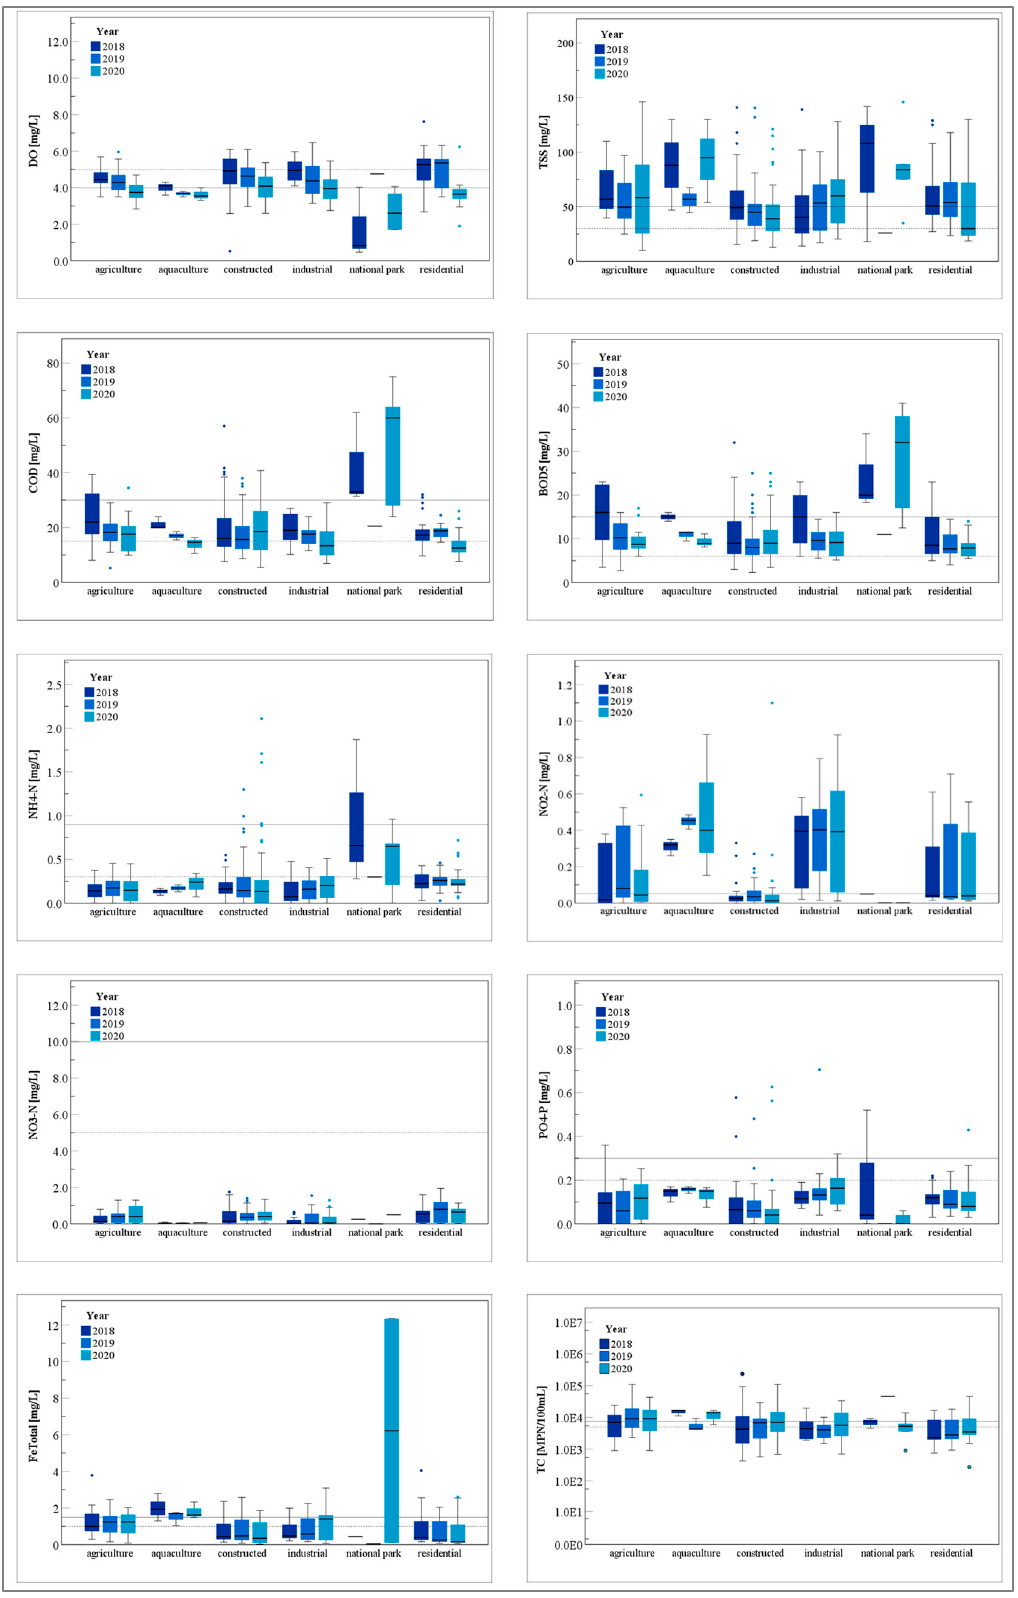
Figure 2. Surface water quality in freshwater monitoring stations at the end of dry season from 2018 to 2020 for main land use types (QCVN A = dashed, QCVN B = line; boxplots showing min, max values with upper (Q3) and lower quartile (Q1) boundaries, median values, and extreme values).